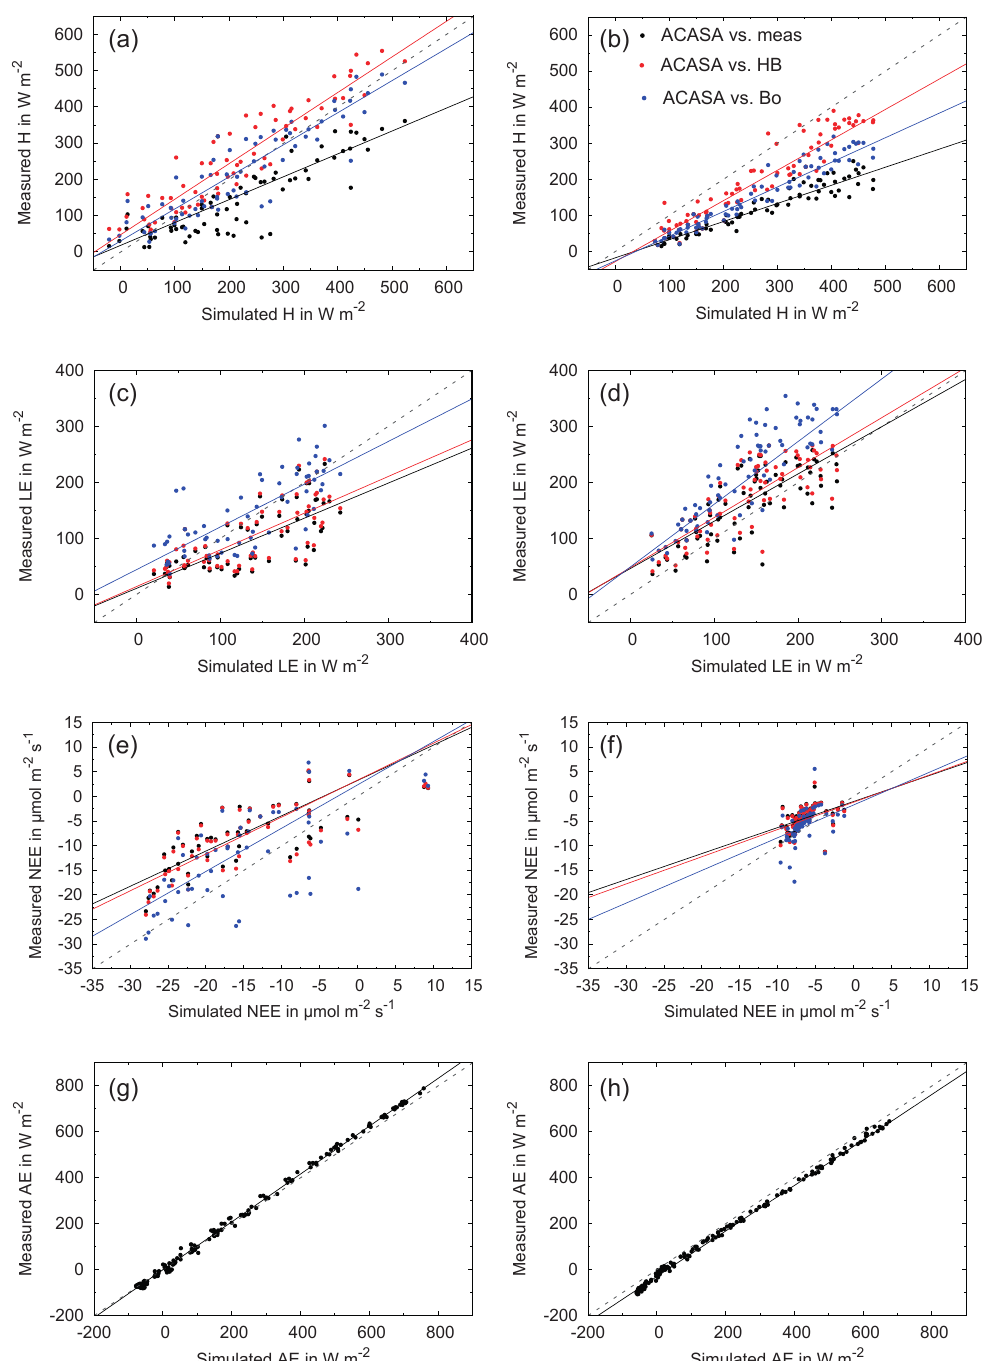
Figure 5. Example of the regression analysis of the measured and the simulated (ACASA) data for GDP 1 for (a, b) the sensible heat flux ( H ); (c, d) the latent heat flux ( LE ); (e, f) the net ecosystem exchange (NEE); and (g, h) the available energy (AE) above the forest (a, c, e, g) and above the clearing at 5.5m of height (footprint-weighted modeled fluxes; b , d , f , h ) for uncorrected (black), Bowen-ratio-corrected (blue), and buoyancy-corrected (red) eddy covariance data. The regression lines are based on binned data for 50Wm − 2 or 2 / 4µmolm − 2 s − 1 classes of the modeled data and an orthogonal regression. The analysis has been achieved for the first and second golden day periods, with Tables 3 and 4 displaying the results of an orthogonal regression with and without assuming a zero intercept for the clearing and the forest,